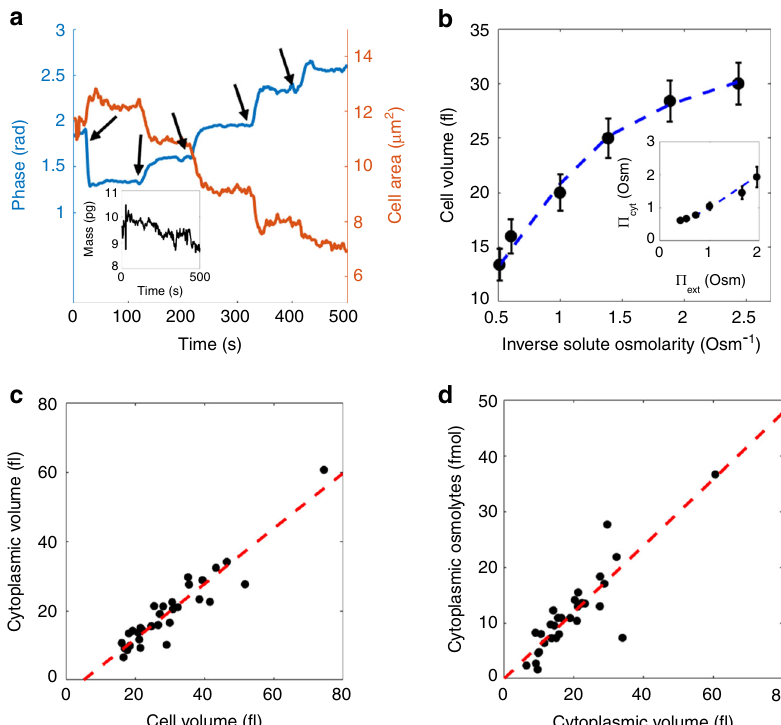
Fig. 2 Response of yeast cells to brief (<10min) osmotic shock. a Characteristic temporal response of phase shift ^ ϕ and area A of a single cell during exposure to a series of solutes having identical RI but increasing osmolarity. The arrows indicate the time points of solute exchange. Inset shows the inferred cell mass, verifying that the observed changes in cell RI and volume are due to out fl ux of water only. b The volume of the cell analyzed in a as a function of inverse osmolarity. The dashed line shows a fi t to the model described in the text. Error bars correspond to the uncertainty in the volume determination estimated in the main text. Inset: The cytosolic osmolarity as a function of external osmolarity. c The estimated cytoplasmic volume (related to the free water content) is linearly related to the cell volume (at external osmolarity Π ext = 0.53 Osm). Small cells show smaller cytoplasmic volume (indicating less free water). d The number of intracellular osmolytes is directly proportional to cytoplasmic volume (at external osmolarity Π ext = 0.53 Osm), suggesting a volume-independent cytoplasmic